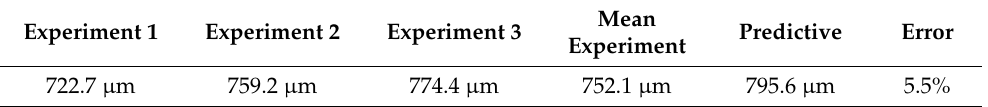
Table 8. Experimental results of the optimal